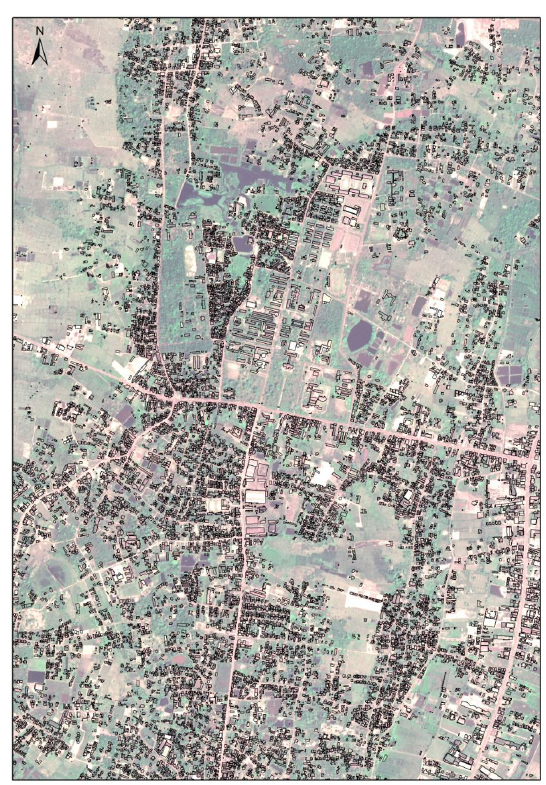
Figure 9. The DOM in Vientiane overlaid with the 1:2000 transportation line graphs provided by